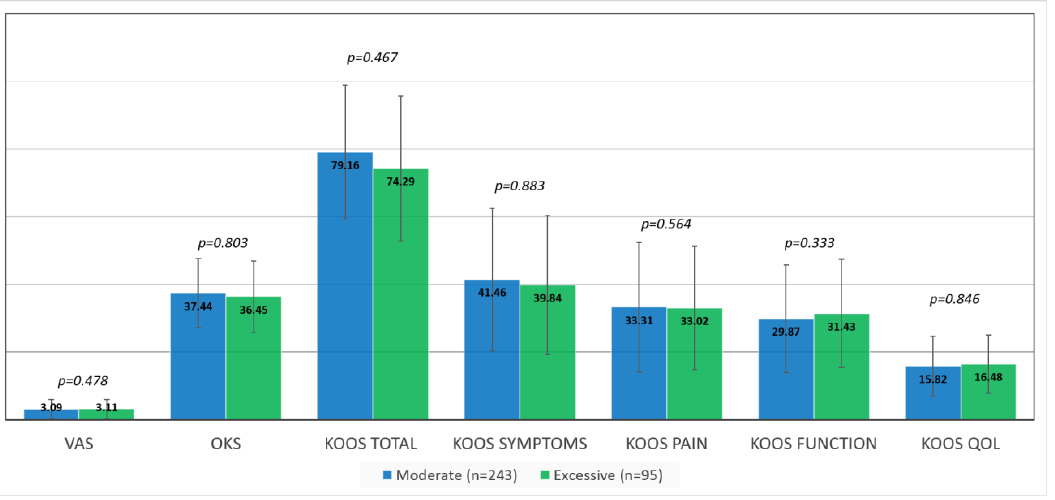
Figure 2. Average patient-reported outcome scores in the moderate versus excessive groups. (KOOS) knee injury and osteoarthritis outcome Score ; (OKS) Oxford knee score; (VAS) visual analog scale; and (QOL) quality of life. Table 3. Number and percentage of patients achieving minimal clinical differences (MCID) of the Oxford knee score (OKS) and the knee injury and osteoarthritis outcome Score (KOOS) subcategories in the moderate versus excessive groups.